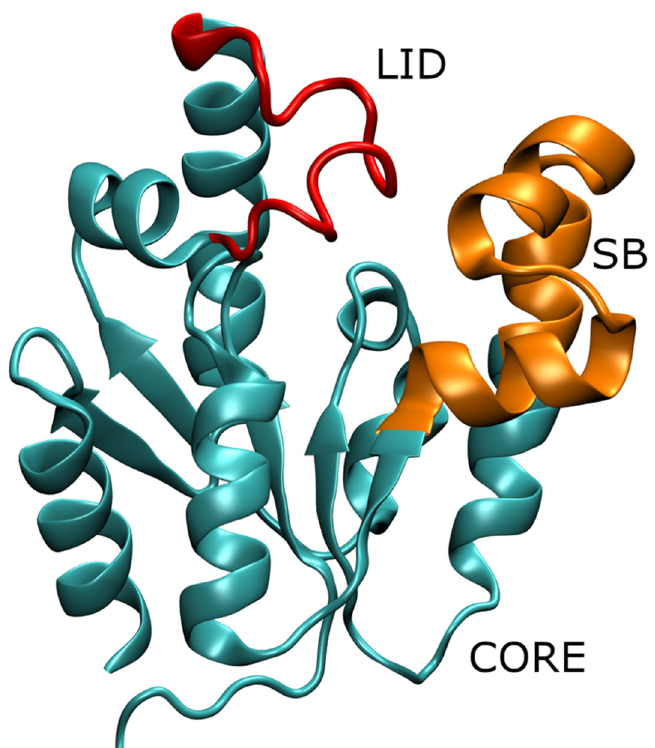
Figure 1. The three main domains in the Shikimate Kinase (SK) enzyme structure: the binding SB (in orange), the LID (in red), and the CORE domains (in turquoise).